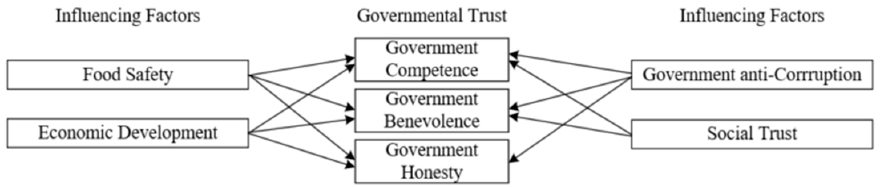
Figure 1. Governmental trust and its influencing factors.